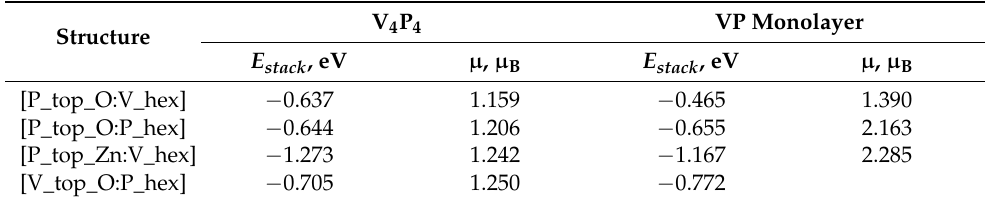
Table 2. Stacking energies and magnetic moments for different VP slab orientation in structures with one and four VP layers.